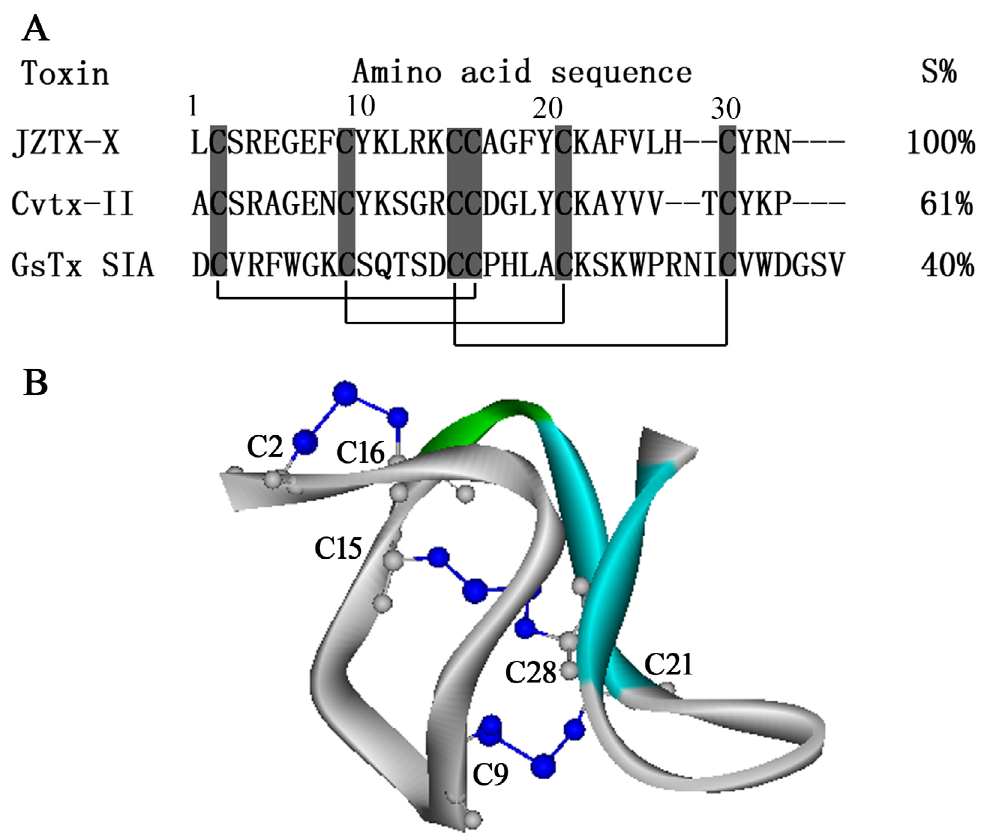
Figure 2. Sequence alignment and structure models of JZTX-X: (A) JZTX-X sequence was aligned with specific toxins obtained from various spider venoms, including Cvtx-II from Coremiocnemis validus [34] and ω-grammotoxin SIA from Grammostola spatulata venom [35]. The similarity percentage was presented relative to JZTX-X. (B) The schematic model of JZTX-X displaying the position of secondary structure: JZTX-X structure models were acquired based on homology modeling according to ω-grammotoxin SIA structure detected by NMR (PDB code: 1KOZ). The schematic models were established by DS ViewerPro. The β-sheet is shown in blue , and the three disulfide bonds (including Cys15–Cys28, Cys9–Cys21, and Cys2–Cys16) are